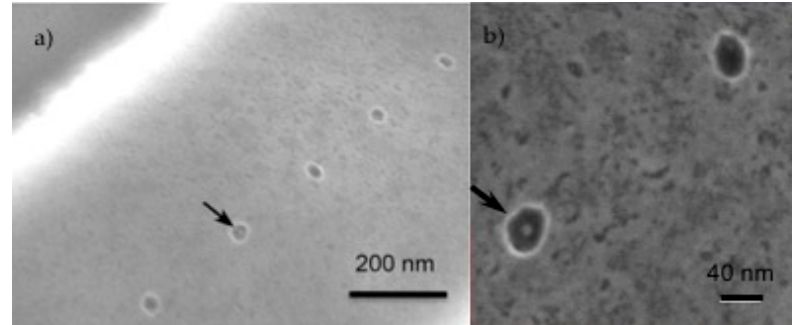
Figure 9. ( a ) SEM image of EPD result with SWCNTs sorted to have an average length 83 ± 26 nm. Higher magnification image ( b ) is reprinted from Kanwal et al. [6] with permission from Elsevier. The deposition time was 10 min at 2.5 V.